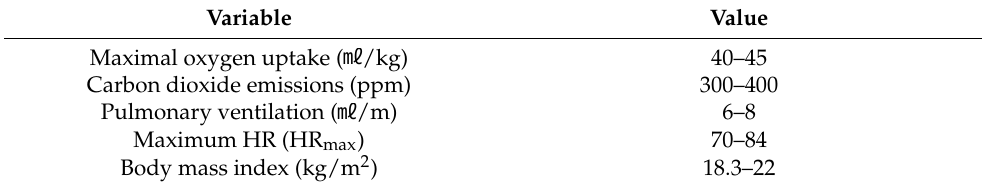
Table 3. Nominal system parameters with different numbers of EE estimation.